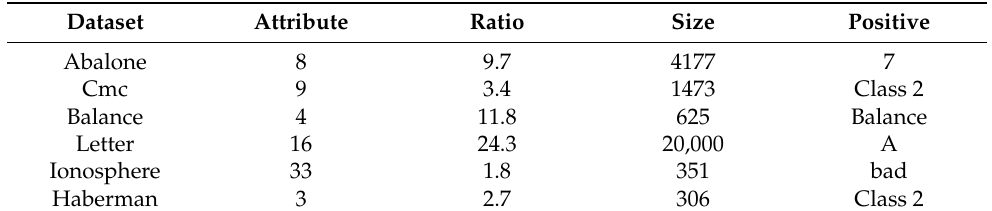
Table 4. UCI data sets.